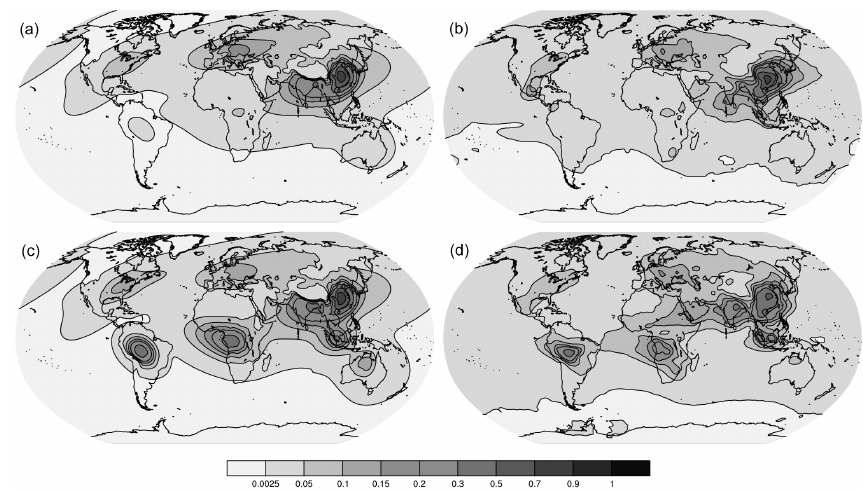
Figure 11. Anthropogenic aerosol optical depth (550nm), for March and September, from MACv2-SP and MACv2. MACv2-SP (March, panel a ; September, panel c ), MACv2 (March, panel b ; September, panel d ). Scale is distorted for low AOD to better illustrate very low values.